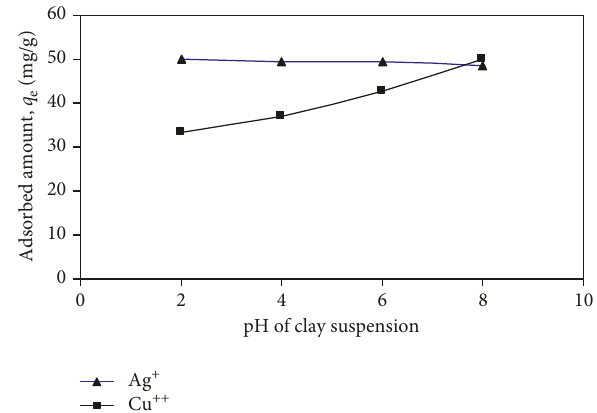
Figure 5: Effect of pH on Ag + and Cu ++ removal by Saudi clay at initial metal concentration concentration � 500mg/L and clay mass � 10g/L.